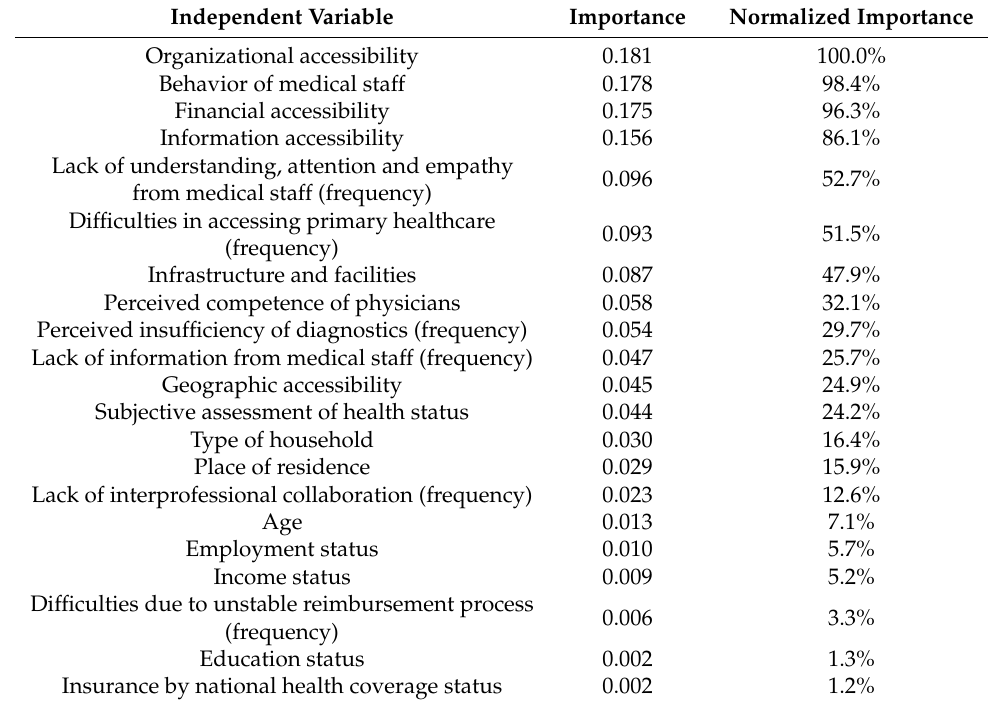
Table 2. The relative importance of explanatory